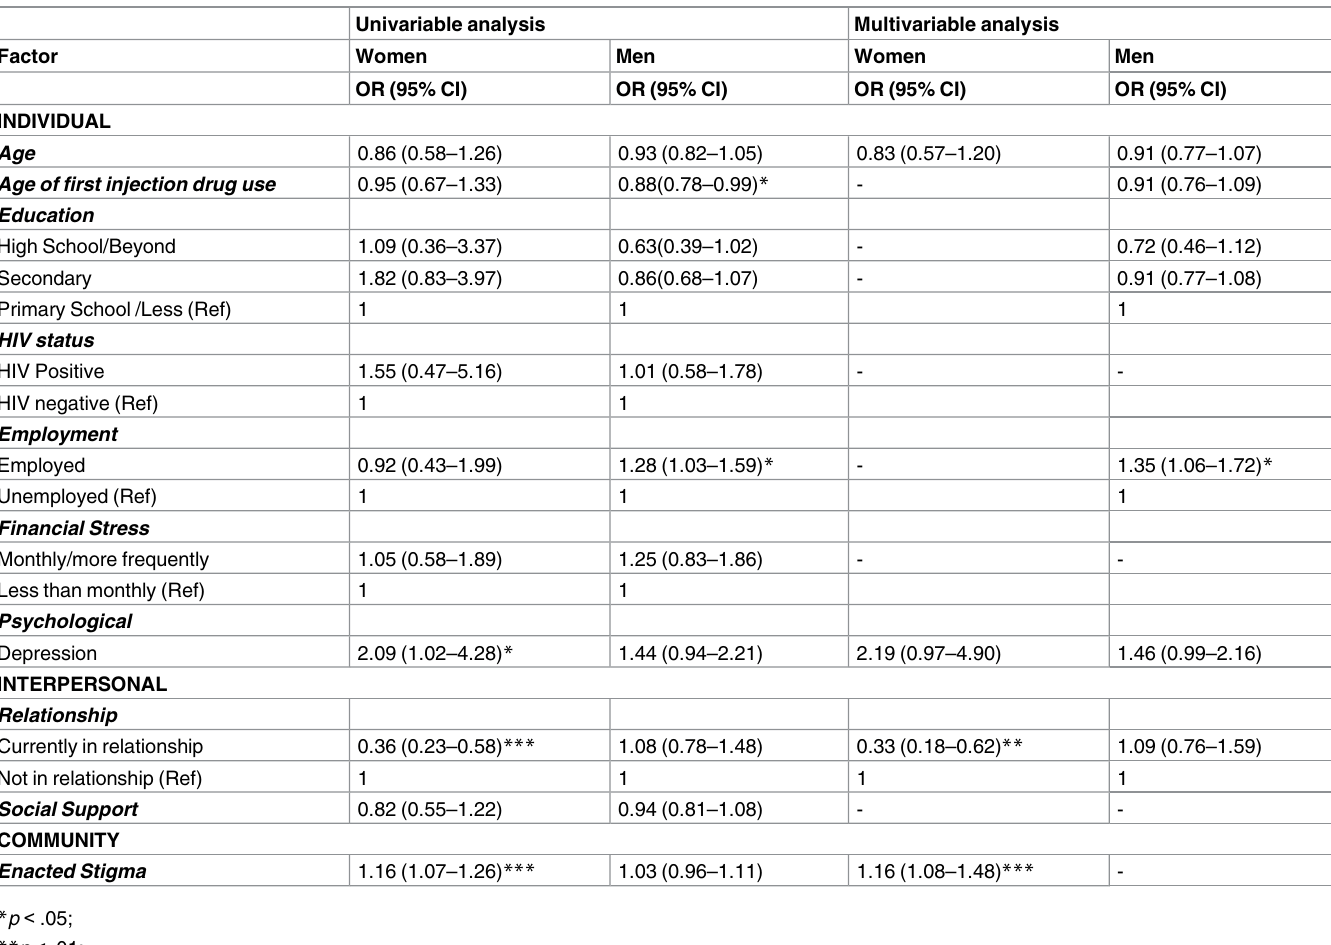
Table 3. Factors associated with multiple recent sex partners in men and women who injected drugs in seven cities in India (N =